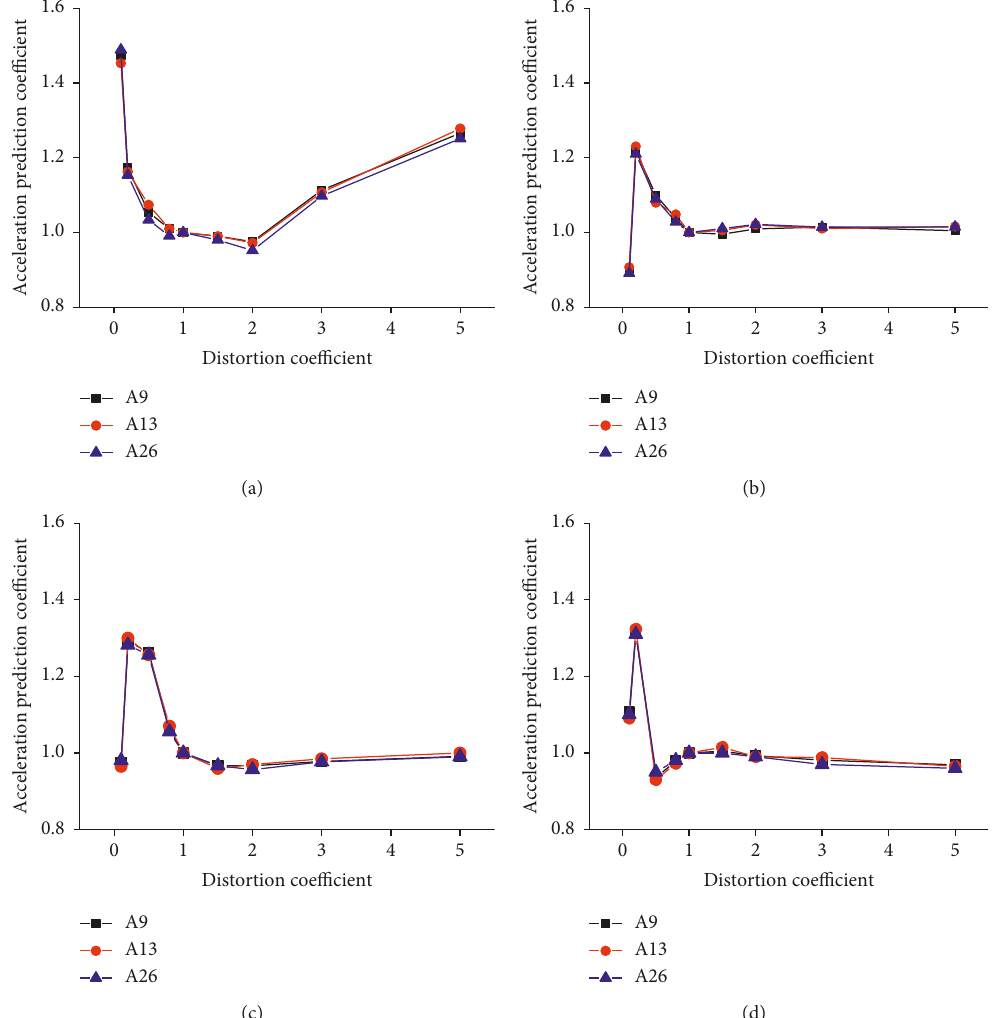
Figure 6: Acceleration prediction coefficient results under different distortion coefficients at monitoring points A9, A13, and A26. (a) EL Centro. (b) Taft. (c) Northridge. (d) Kobe.